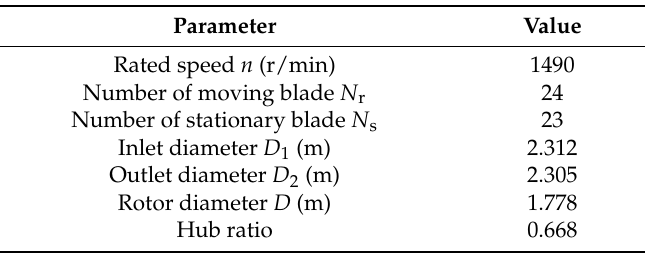
Figure 1. Geometrical model of the axial fan. Table 1. Parameters of the axial